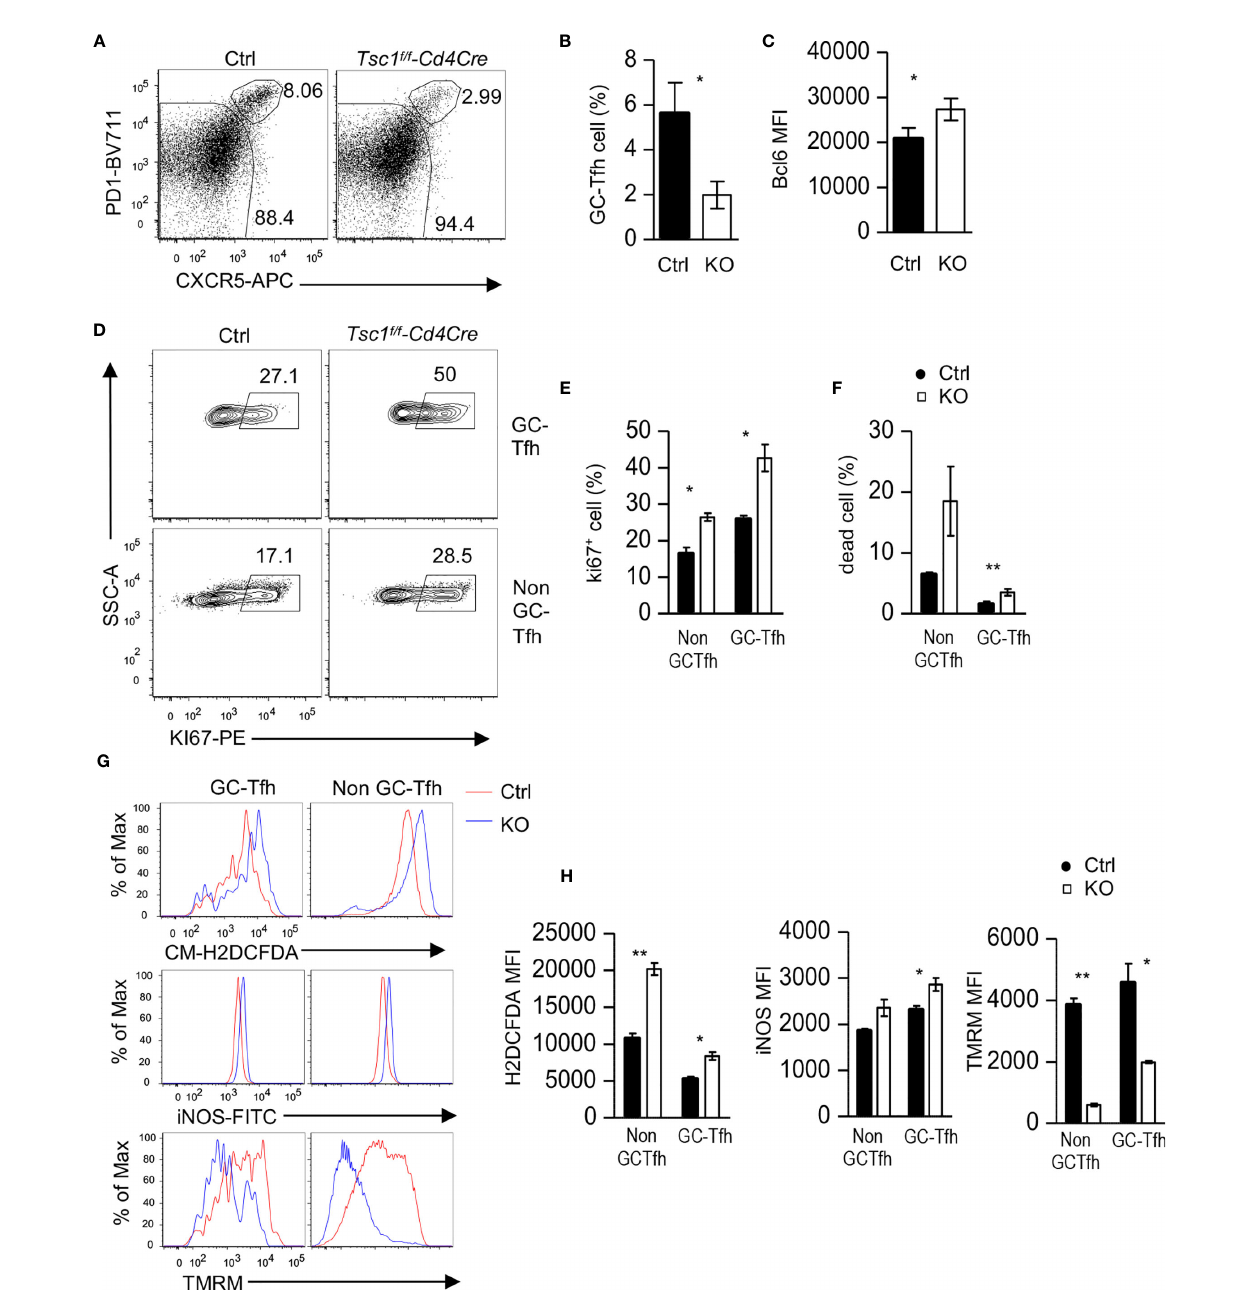
FIGURE 7 | Impaired Tfh responses to antigen immunization in Tsc1-de fi cient mice. Splenocytes from Tsc1 f/f -Cd4Cre and control mice 10 days after immunization with NP 17 -CGG in alum were analyzed. (A) FACS plots show CXCR5 and PD1 staining in live gated CD4 + TCR b + CD44 + CD2L - effective T cells. (B) Bar graphs represent mean ± SEM of GC-Tfh cell percentages. (C) Bar graphs represent mean ± SEM of MFI of Bcl6 in GC-Tfh cells. (D) Representative FACS plots show Ki67 staining in GC-Tfh and non-GC-Tfh cells. (E) Bar graphs represent the mean ± SEM of Ki67 + cells in GC-Tfh and non-GC-Tfh cells. (F) Bar graphs represent mean ± SEM of death rates of GC-Tfh and non-GC-Tfh cells. (G, H) Overlaid histograms show staining of CM-H2DCFDA (ROS), iNOS, and TMRM in GC-Tfh and non-GC- Tfh cells. (H) Bar graphs represent the mean ± SEM of MFI of H2DCFDA, iNOS, and TMRM in GC-Tfh and non-GC-Tfh cells. Data shown are representative of or pooled from three experiments. * p < 0.05; ** p < 0.01, determined by an unpaired two-tailed Student